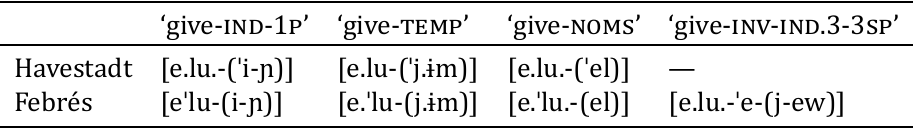
Table 11: Stem-(cid:976)inal vs. penultimate mora stress in Havestadt and Febrés (right-aligned moraic trochee in